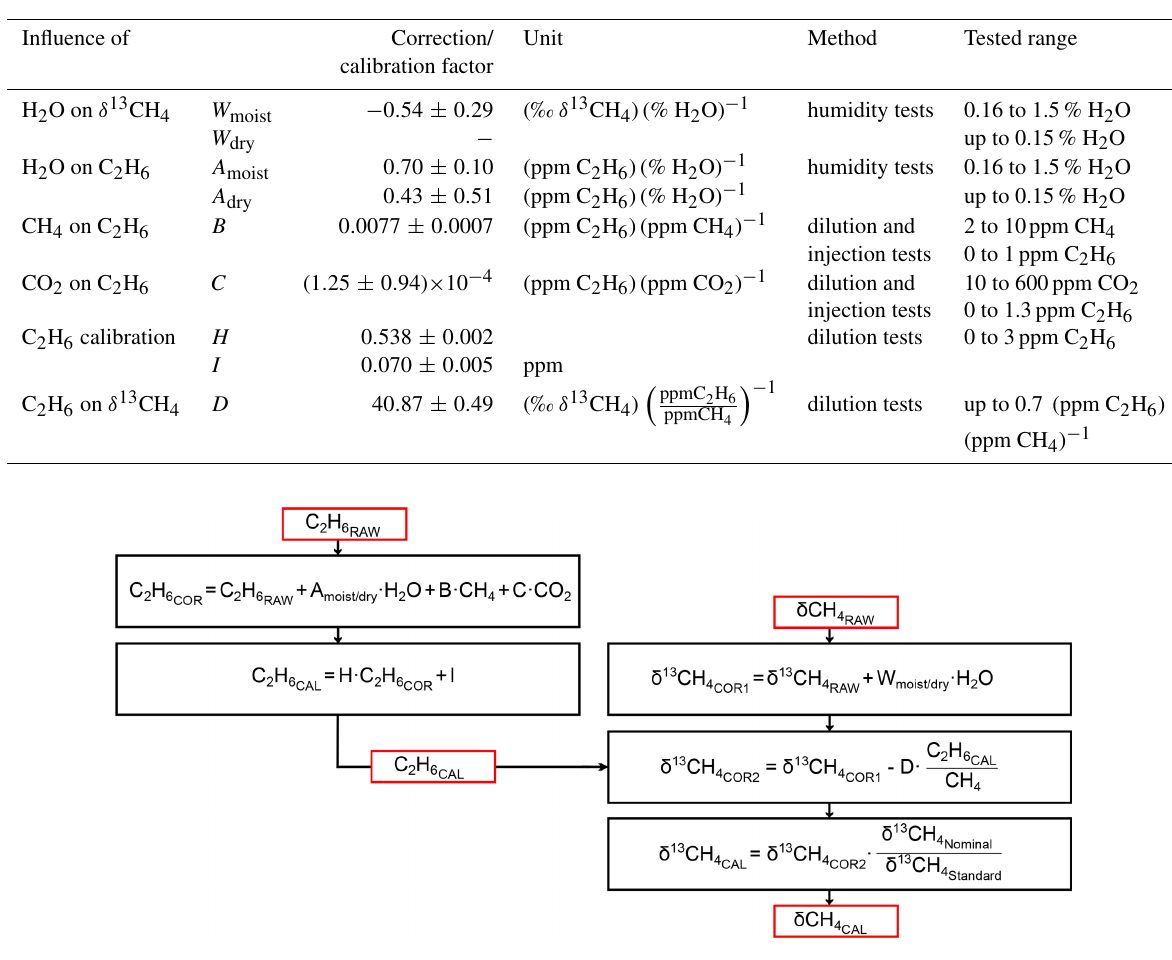
Figure 3. Scheme to correct and calibrate C 2 H 6 and δ 13 CH 4 . δ 13 CH 4 the measured (or interpolated) value of the calibration standard. The values for the correction and calibration factors are summarised in Table